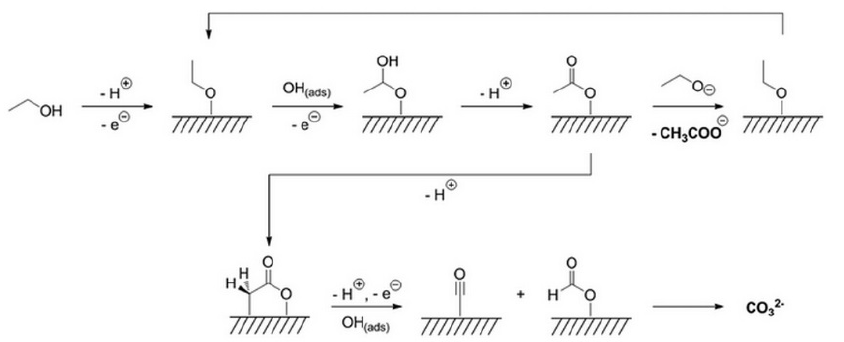
Figure 3. The mechanism of ethanol oxidation at polycrystalline Pt in alkaline solutions proposed by Christensen. Reproduced with permission from Reference [20] Copyright 2012, American Chemical